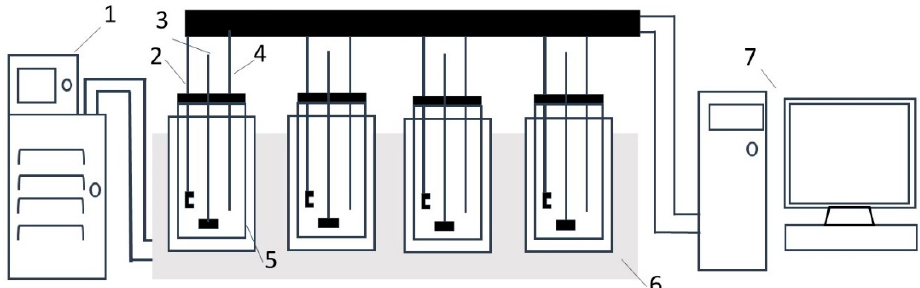
Figure1. SchematicrepresentationoftheCrystalScan. ( 1 )Programmablethermostaticbath; ( 2 Figure 1. Schematic representation of the Crystal Scan. ( 1 ) Programmable thermostatic bath; ( 2 ) 100 turbidity probes; ( 3 ) overhead stirrer; ( 4 ) temperature probes; ( 5 ) crystallizer; ( 6 ) poly-block; ( 7 ) 101 computer. 102